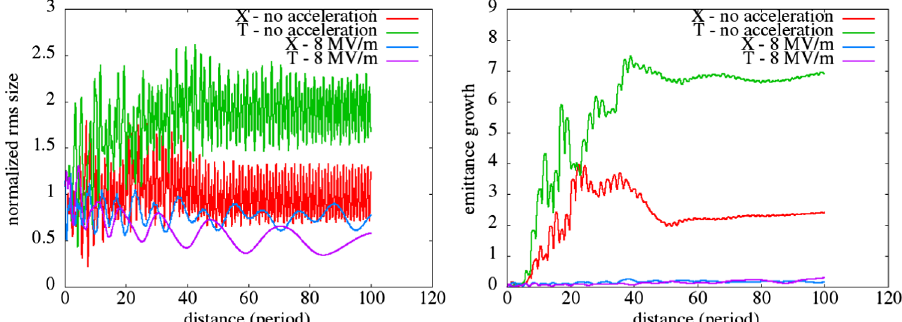
FIG. 3. The horizontal and longitudinal normalized rms size evolution (left) and emittance growth evolution (right) inside the solenoid-rf channel without acceleration and with acceleration. The depressed transverse phase advance is 40 degrees with 120 degree zero current transverse and longitudinal phase advances.